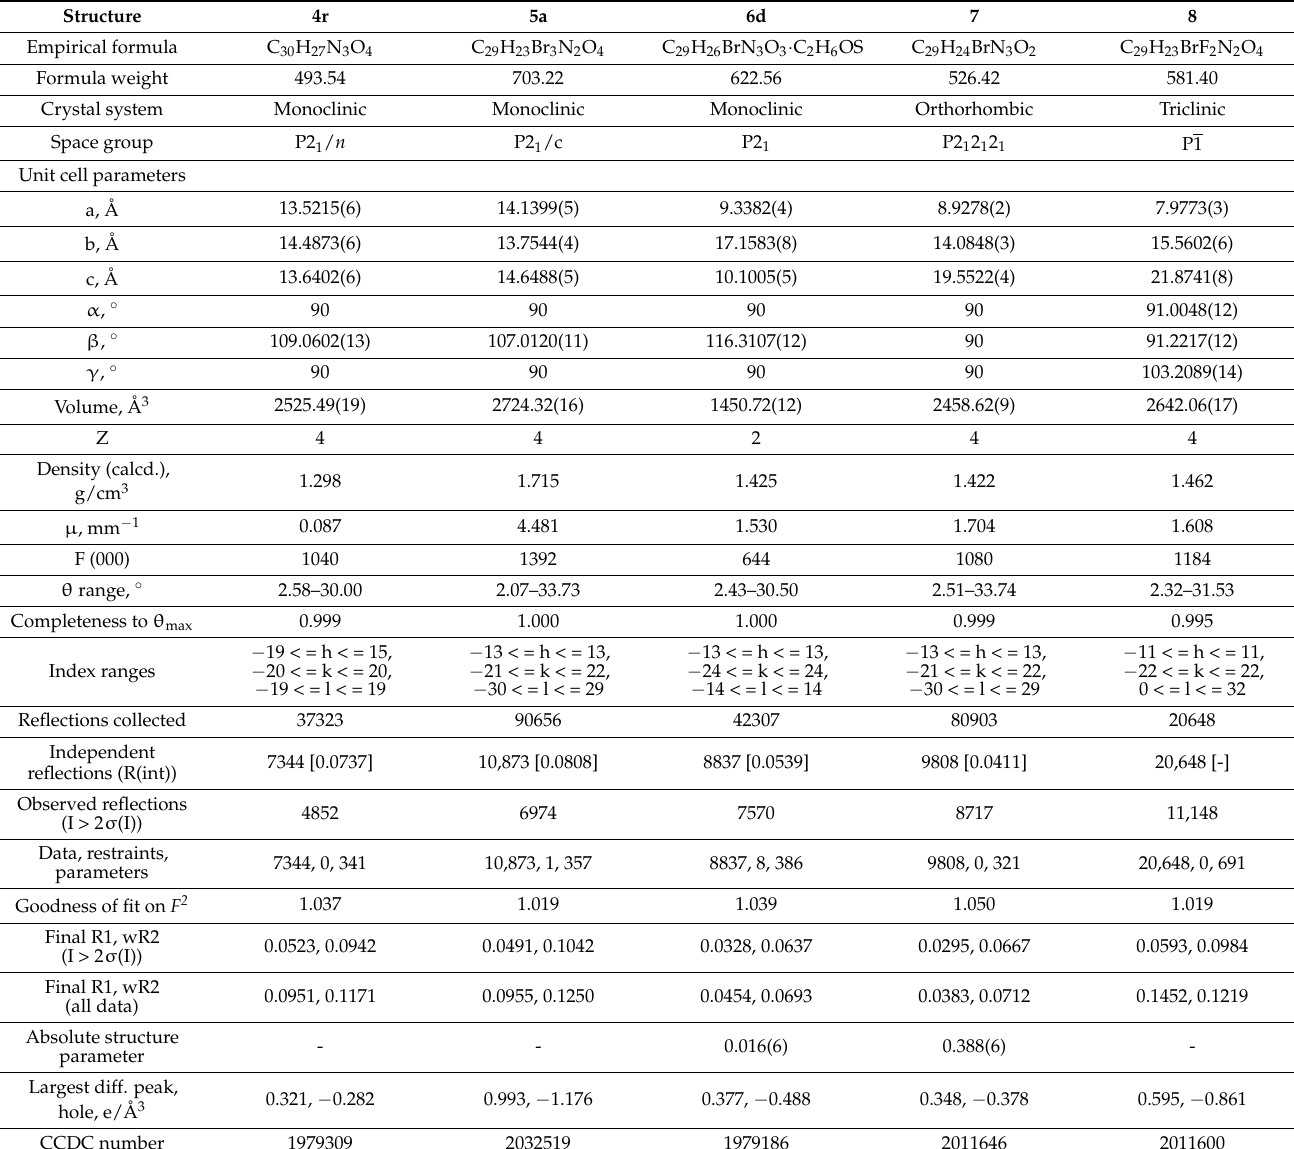
Table 4. Crystal data and structure